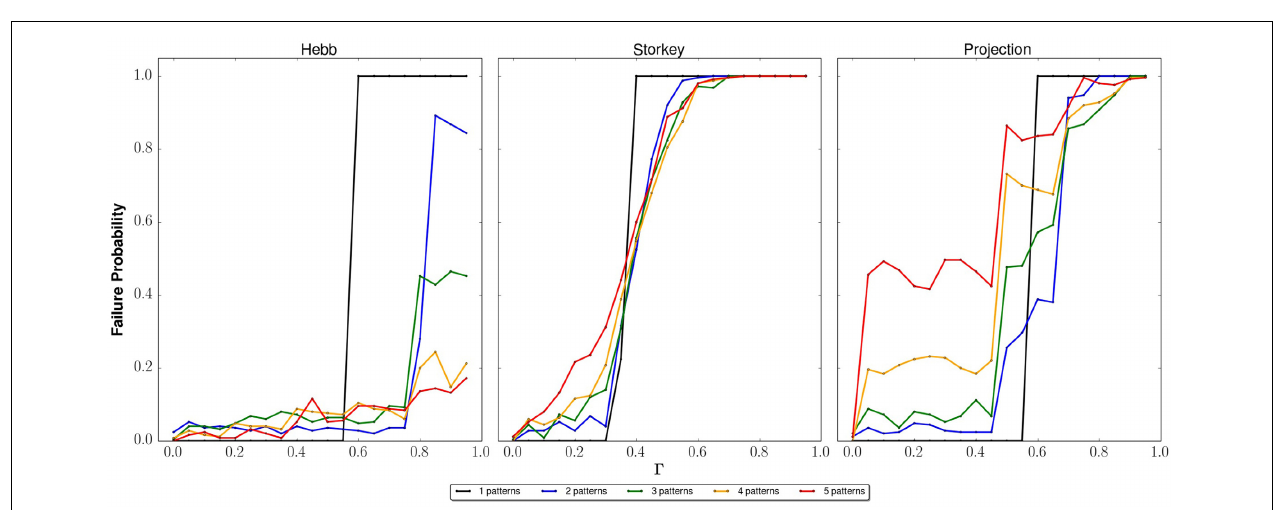
probability of a learning rule (Hebb, Storkey, projection) using an input state that is Hamming distance 1 from a stored memory. Failure increases with (cid:6) when the non-memory input state forms a fixed point in the network.